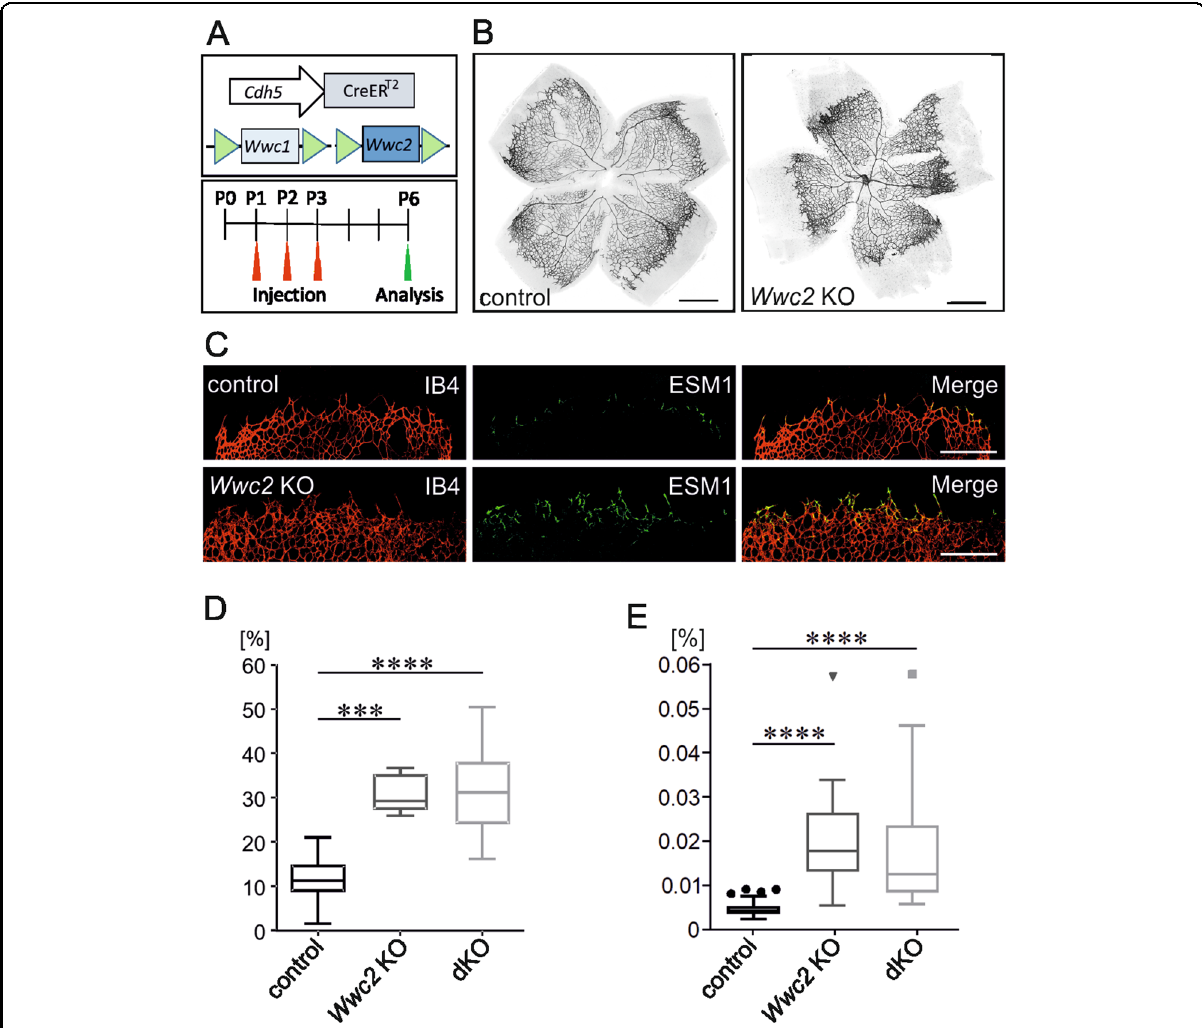
Fig. 6 Disturbed postnatal angiogenesis and vascular hypersprouting in retina from Wwc2 KO mice. A Scheme describing the endothelial- speci fi c deletion of Wwc1 and Wwc2 in postnatal Cdh5 - Cre ER T2 mice that was achieved by an intragastric Tamoxifen injection (50 µl of a Tamoxifen stem solution (1 mg/ml)) at P1 – P3. At P6, mice were euthanized and retinas were dissected. B IB4-stained vessels in retina fl at mounts from control and Wwc2 KO mice. C Vascular front region in fl at mounts stained for vessels (IB4) and leading tips cells (ESM1). D Percentage of the area of vascular hypersprouting compared to total vascular area in controls and Wwc2 KO retinas. E Ratio of the number of vascular endpoints in relation to the total vessel length in controls and Wwc2 KO retinas. Data in D and E are presented as box plots according to Tukey, i.e. whiskers have a maximum length of 1.5 interquartile length, and the symbols (circles, triangle, square) represent outliers. Statistical signi fi cance of differences is indicated as follows: *** p < 0.001, **** p <